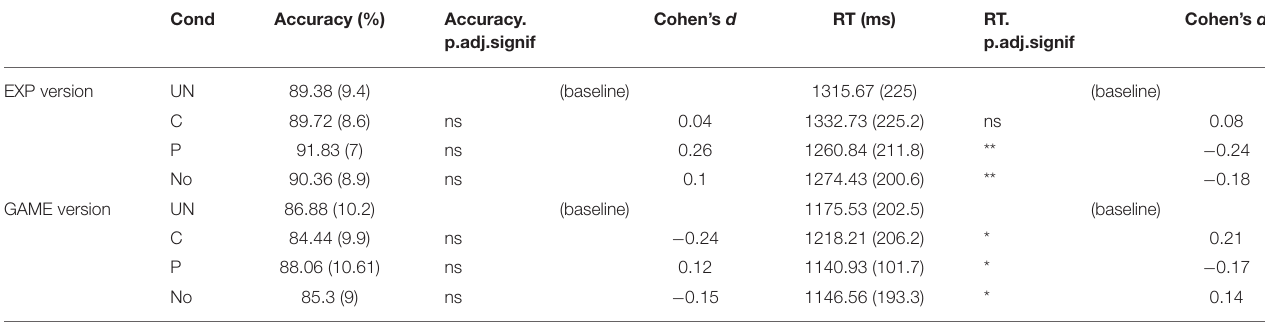
TABLE 2 | Experiment 2: Accuracy (%) and RT (ms) are shown as mean (s.d.).